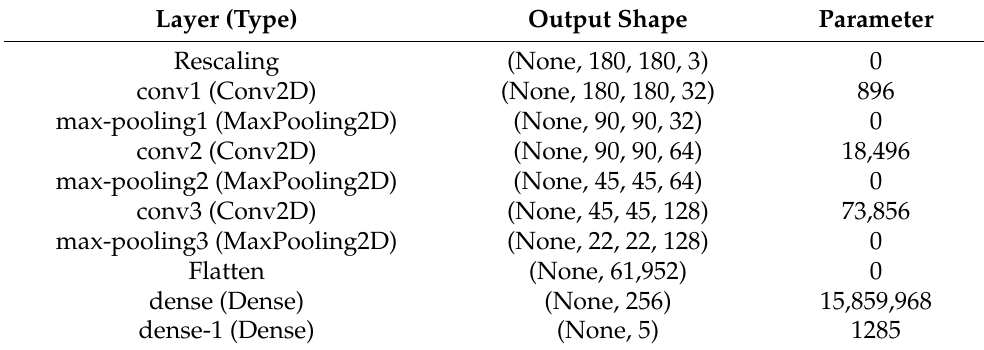
Table 1. Some layers of the neural network used for object classification training.